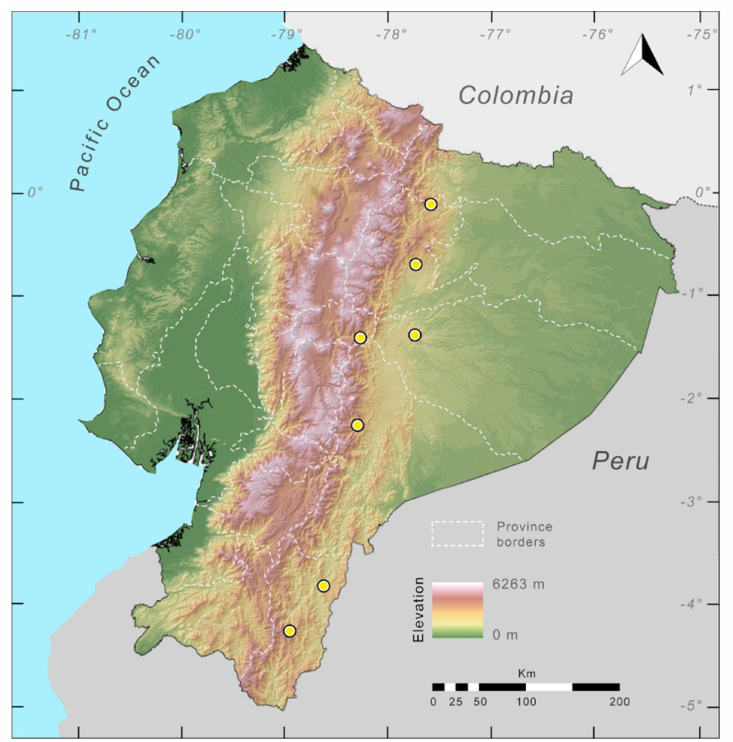
Figure 65. Distribution of Chimerella mariaelenae in Ecuador (yellow